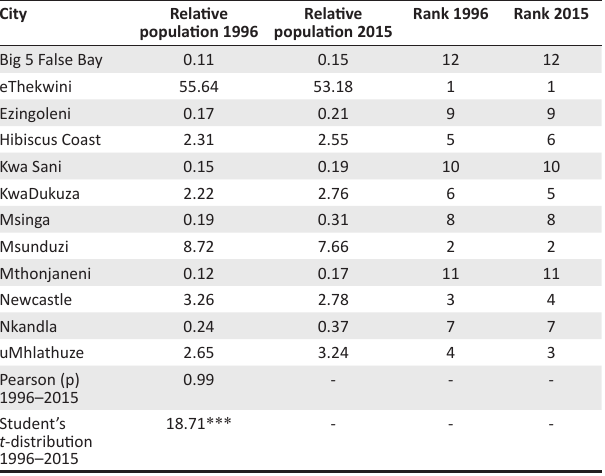
TABLE 7: The relative city size of KwaZulu-Natal cities. City Relative Relative Rank 1996 Rank population 1996 population 2015